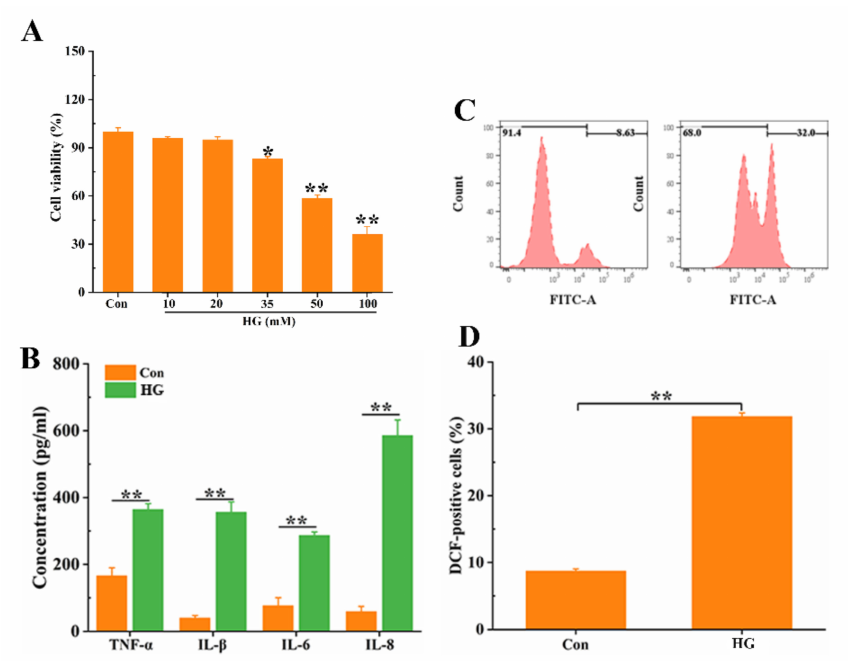
Figure 1. HG-induced oral mucosal cell inflammatory responses. ( A ) HG-induced oral mucosal cell viability. The oral mucosal cells were treated with different concentrations of glucose (0, 10, 20, 35, 50, and 100 mM) for 48 h, and cell viability was examined by CCK-8 assay. After treatment with 50 mM glucose, inflammatory ( B ) and ROS ( C , D ) were detected. * p < 0.05, ** p <